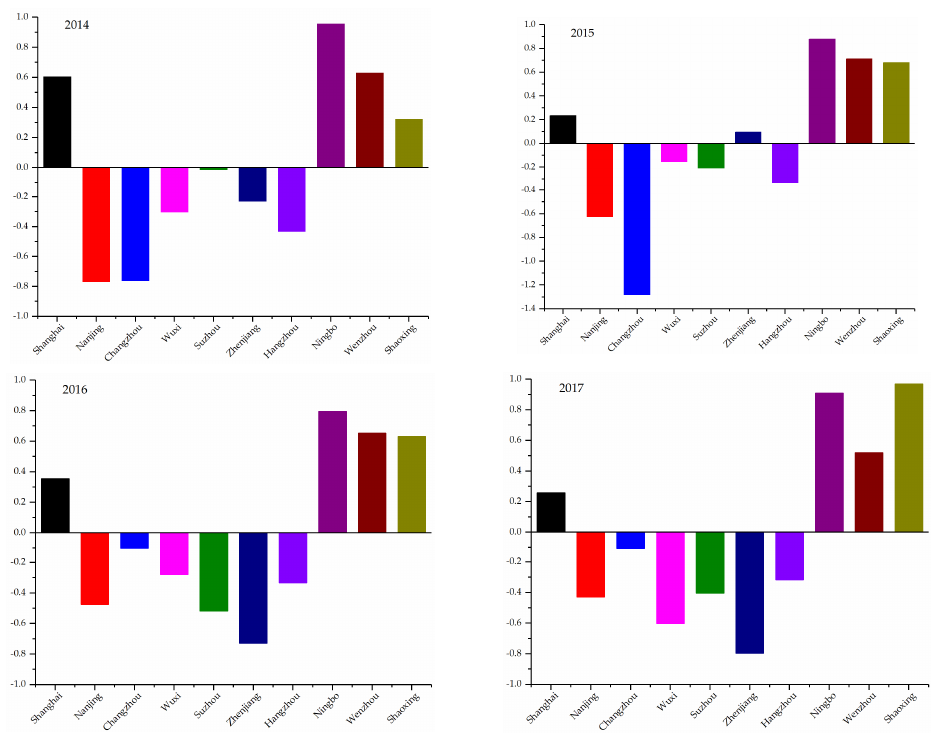
Figure 1. The net flow of eleven regions from 2014 to 2017.